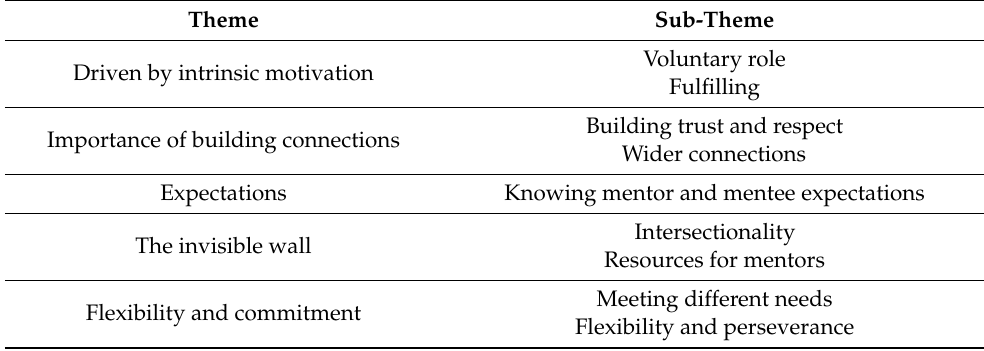
Table 1. Mentors’ insights into the Empowerment and Peer Mentoring of Migrant and Refugee Women pilot program